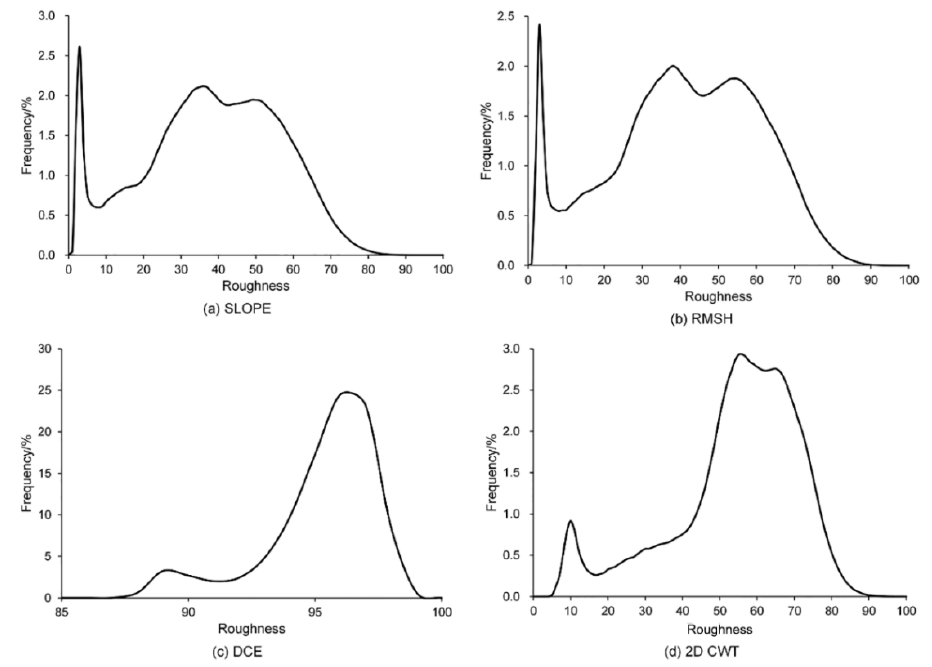
Figure 8. ( a )Frequency distribution curves of SLOPE after mean filtering; ( b ) Frequency distribution curves of RMSH after mean filtering; ( c ) Frequency distribution curves of DCE after mean filtering; ( d ) Frequency distribution curves of 2D CWT after mean filtering